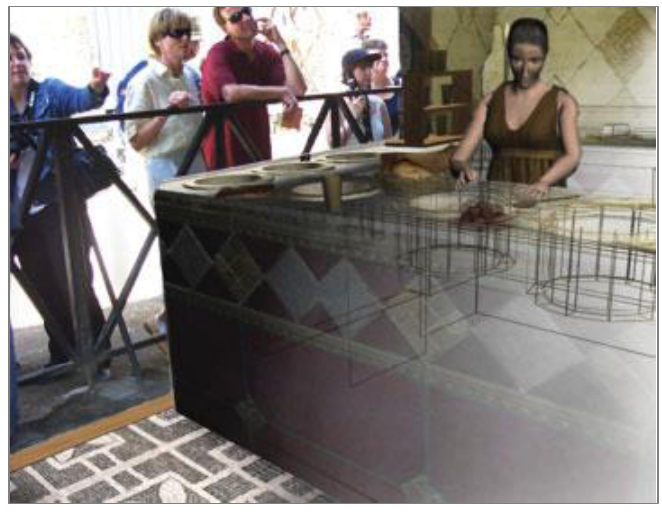
Figure 4 Thermopolium, AR character preparing food (Papagiannakis et al. 2005)